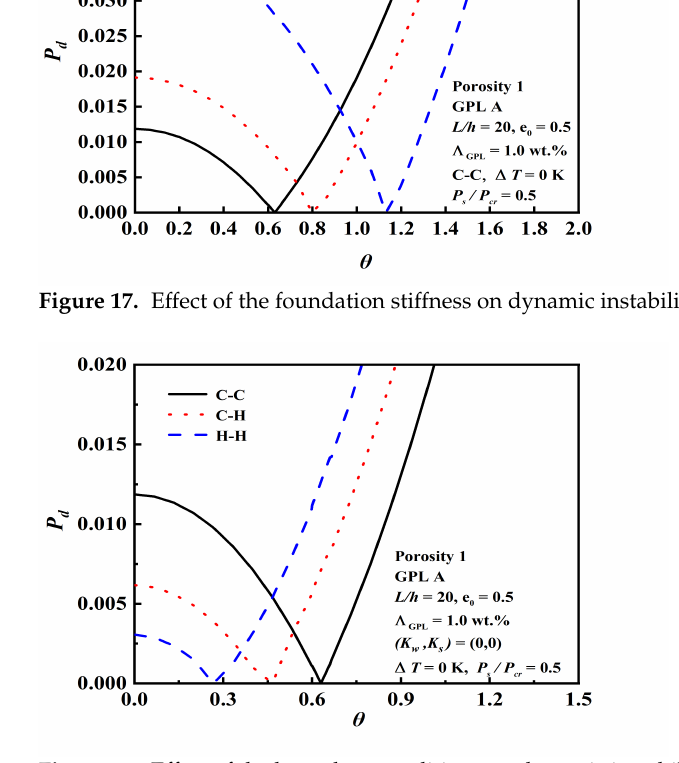
Figure 18. Effect of the boundary conditions on dynamic